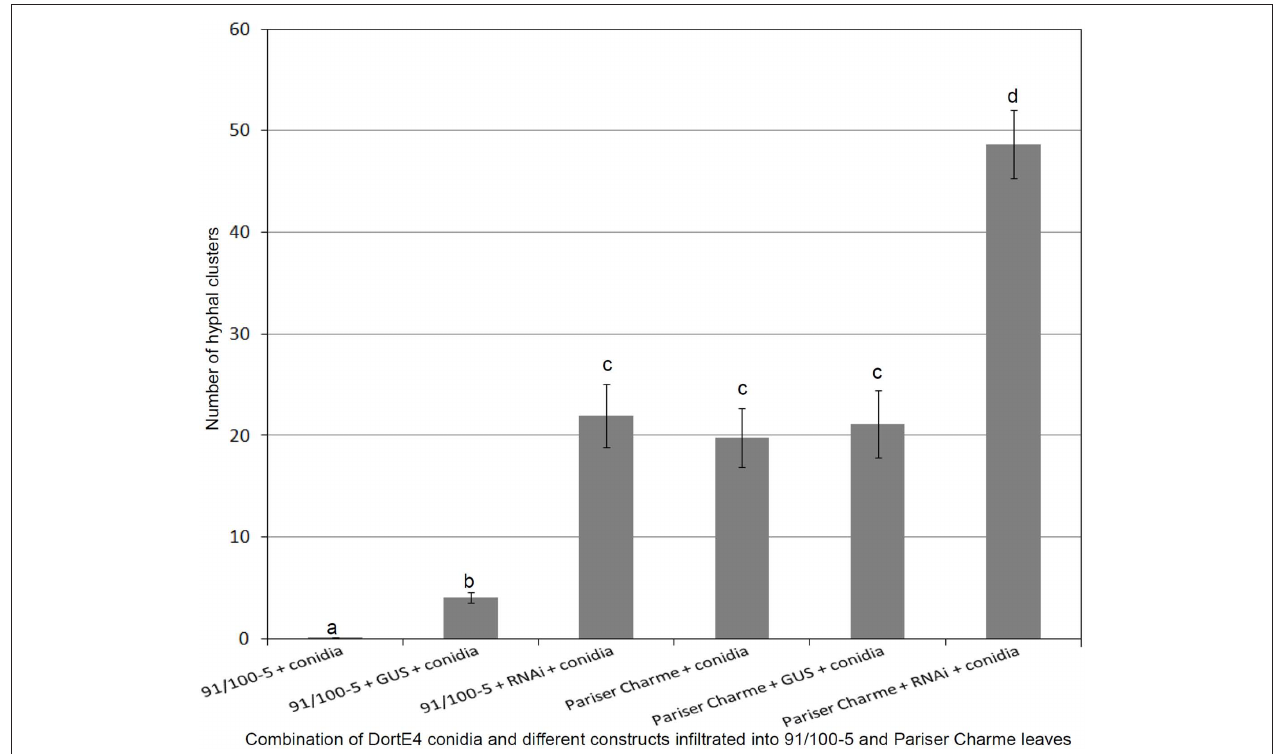
Figure 4 | results of the transient silencing experiment in genotype 91/100-5 and Pariser Charme rose leaves. Values are averages for 20 replications each ± SEM. The number of hyphal clusters are significantly increased in 91/100-5 leaves carrying Rdr1 –RNAi construct. Results with same letters are not significantly different ( P <